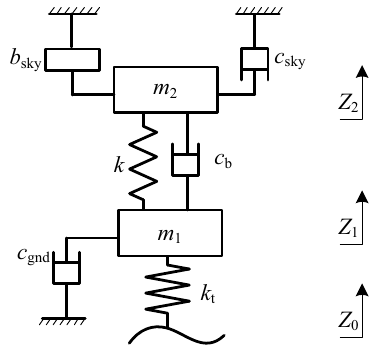
Figure 1. The 2DOF model of the multi-hook suspension